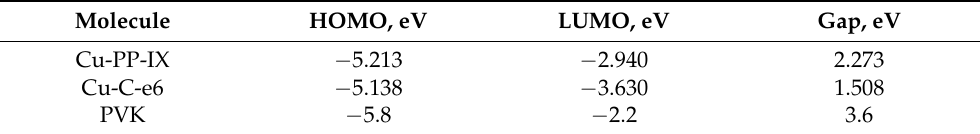
Figure 6. Cyclic voltammograms of ( a ) Cu ‐ PP ‐ IX and ( b ) Cu ‐ C ‐ e6 (blue curves). The red lines show the tangents to the curves. The accuracy of the CV experiments is ±0.02 V. Table 1. Energy of the HOMO and LUMO levels.